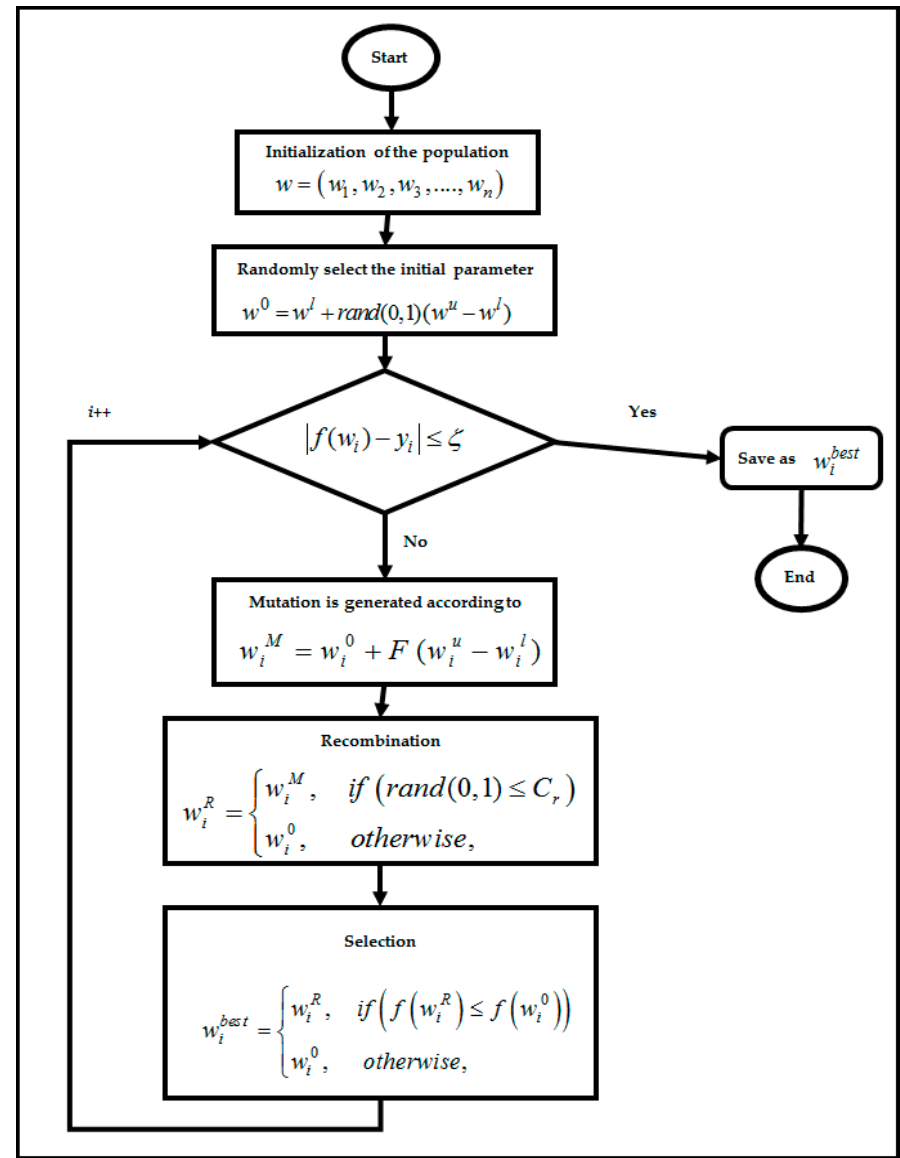
Figure 4. Flowchart of RBFNN-2SATRADE. Note: the implementation of differential evolution (DE) in RBFNN-2SATRA is defined as RBFNN-2SATRADE.